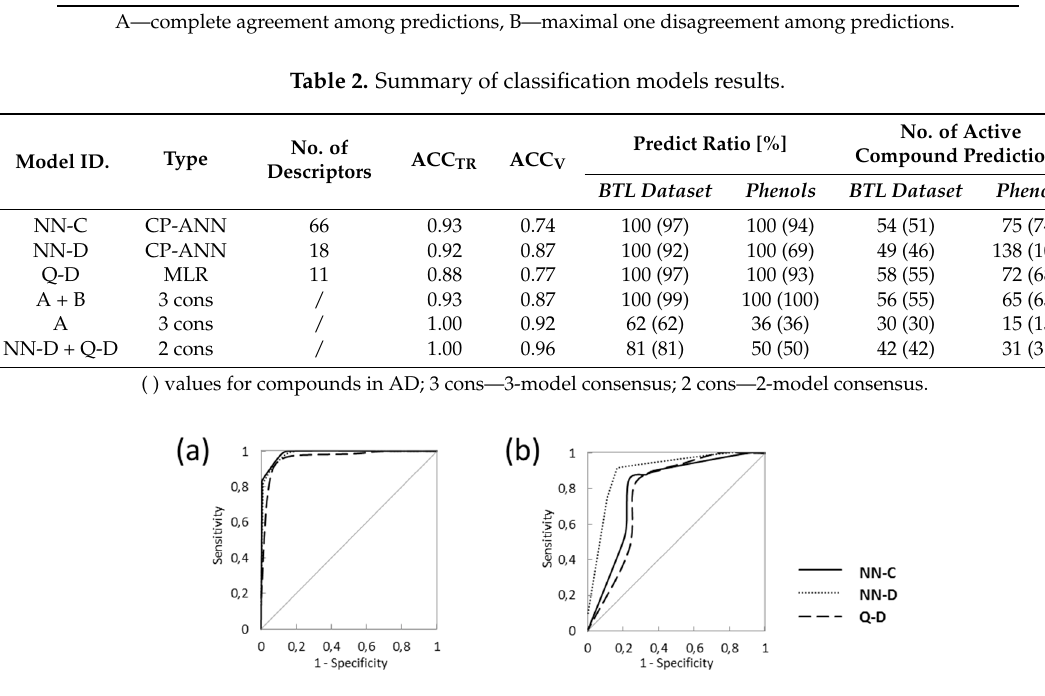
Figure 3. ROC curves of the three selected classification models: ( a ) training set, ( b ) validation set.